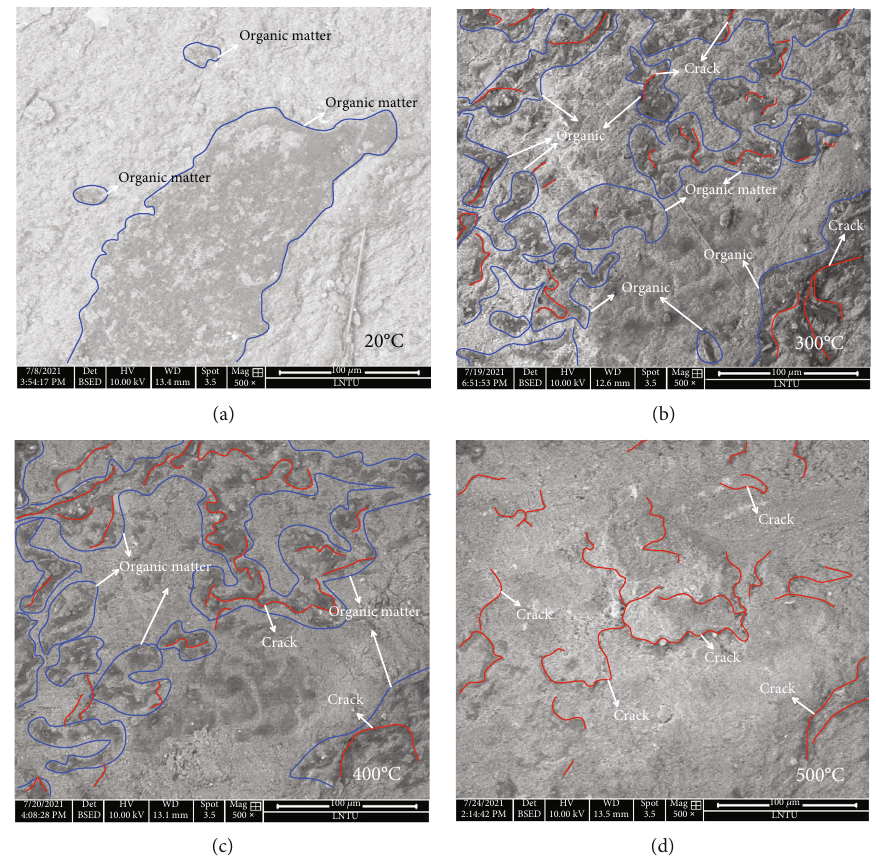
Figure 11: Scanning electron microscopy images of oil shale before and after microwave heating. (a) Oil shale in initial state. (b) Oil shale at 300 ° C. (c) Oil shale at 400 ° C. (d) Oil shale at 500 °